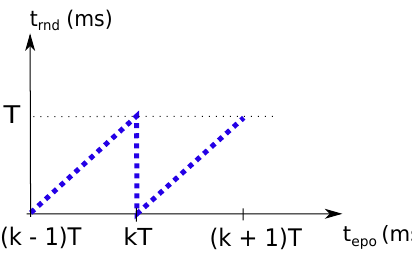
Figure 3. Round-time t rnd is a modulo T representation of epoch time t epo .